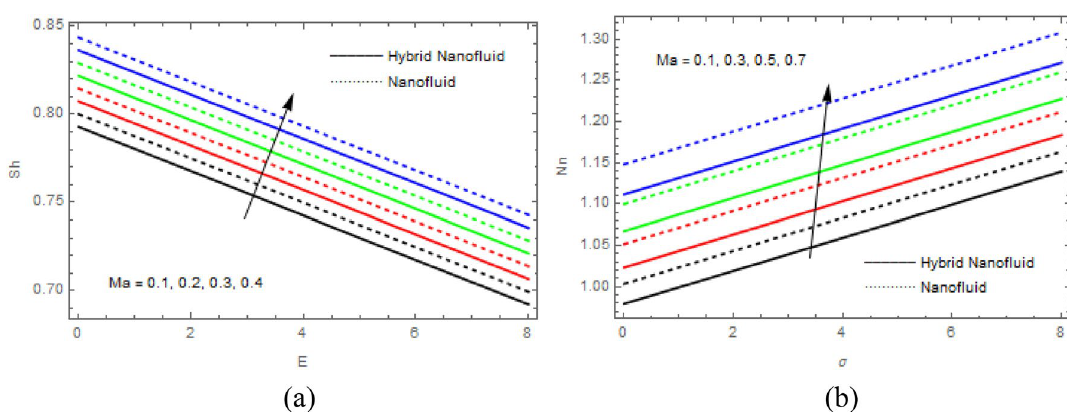
Figure 20. ( a , b ) Influence of Ma on Sh and Nn